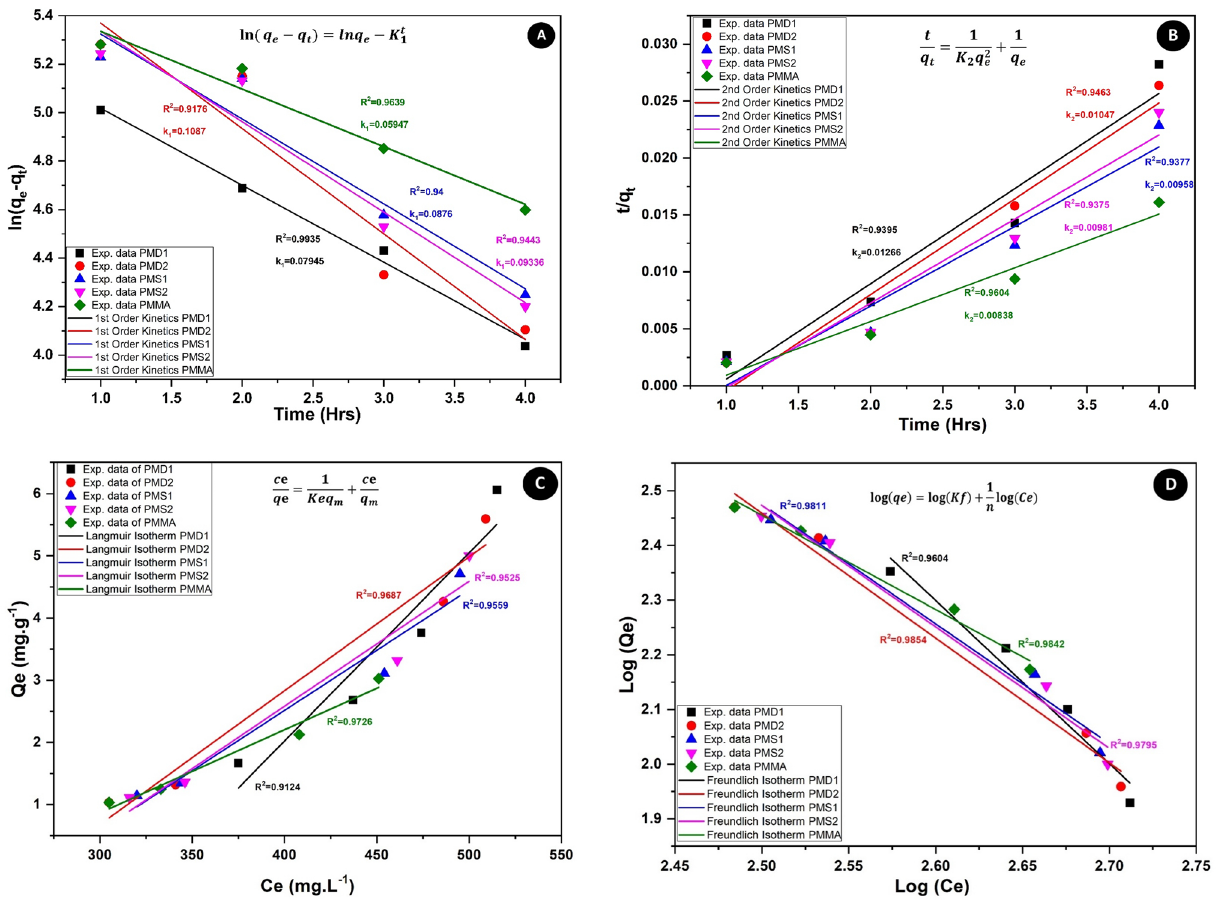
Figure 8. ( A ) Pseudo 1st order, ( B ) Pseudo 2nd order rate curves obtained from adsorption of BSA on polymers, ( C ) Langmuir isotherm and ( D ) Freundlich isotherm.